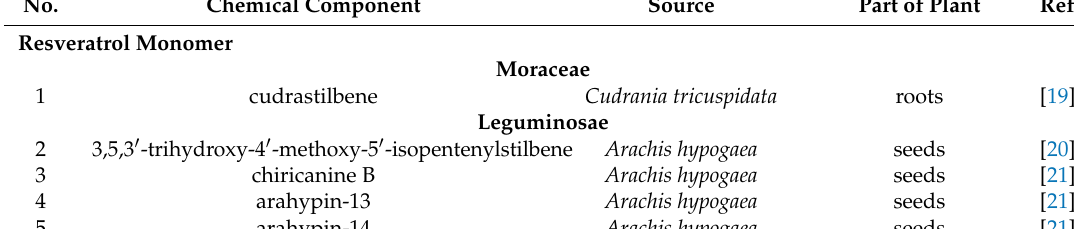
Table A1. The novel resveratrol oligomers isolated from plants over the period from 2010 to present.